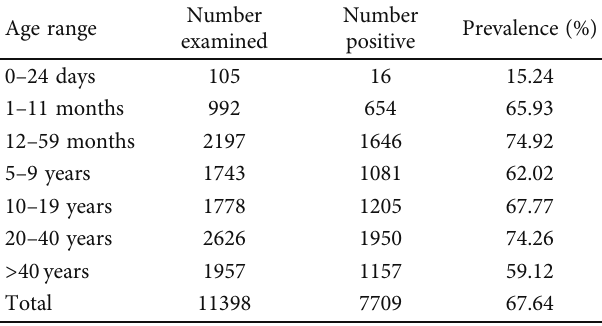
Table 3: Prevalence of malaria infection in relation to age in Akure North Local Government Area of Ondo State,